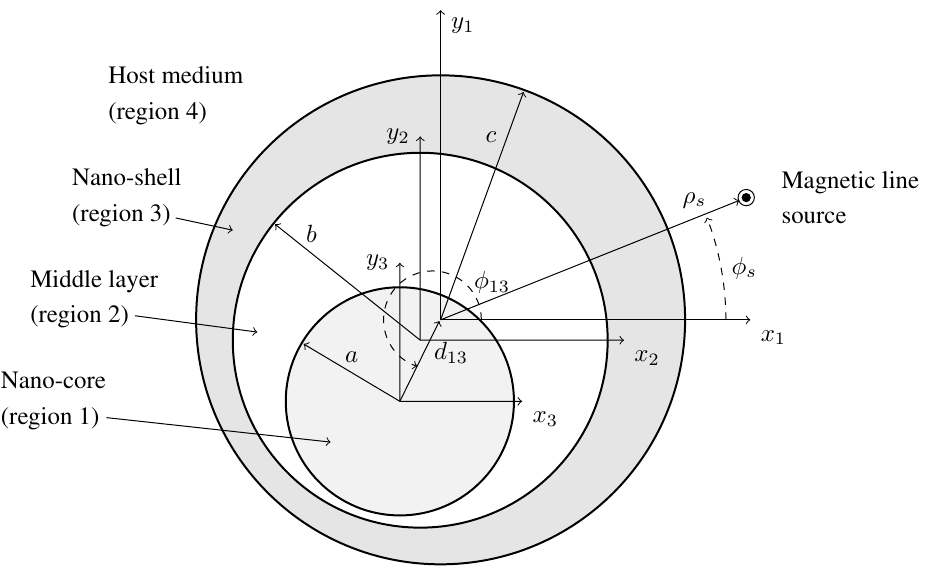
Figure 1. The configuration of the eccentric three-layer NP excited by a near-by magnetic line